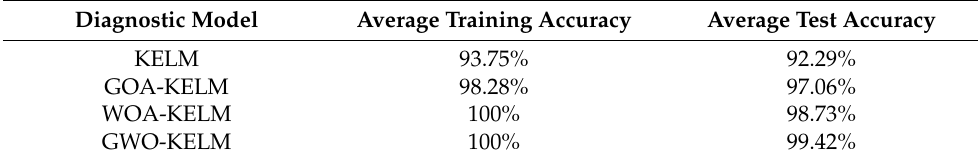
Table 4. Comparison of results of different models.